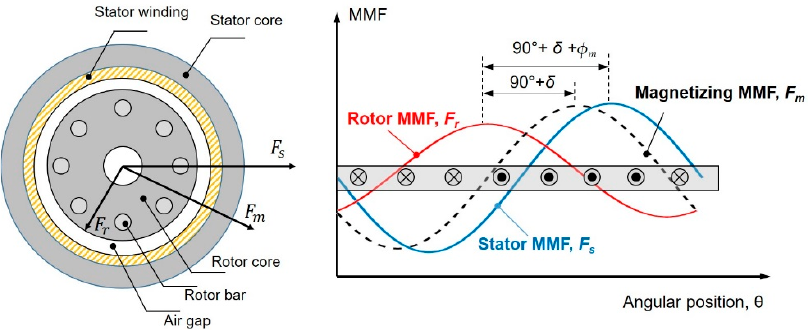
Figure 1. Schematic diagram for the description of MMF components in an induction machine.